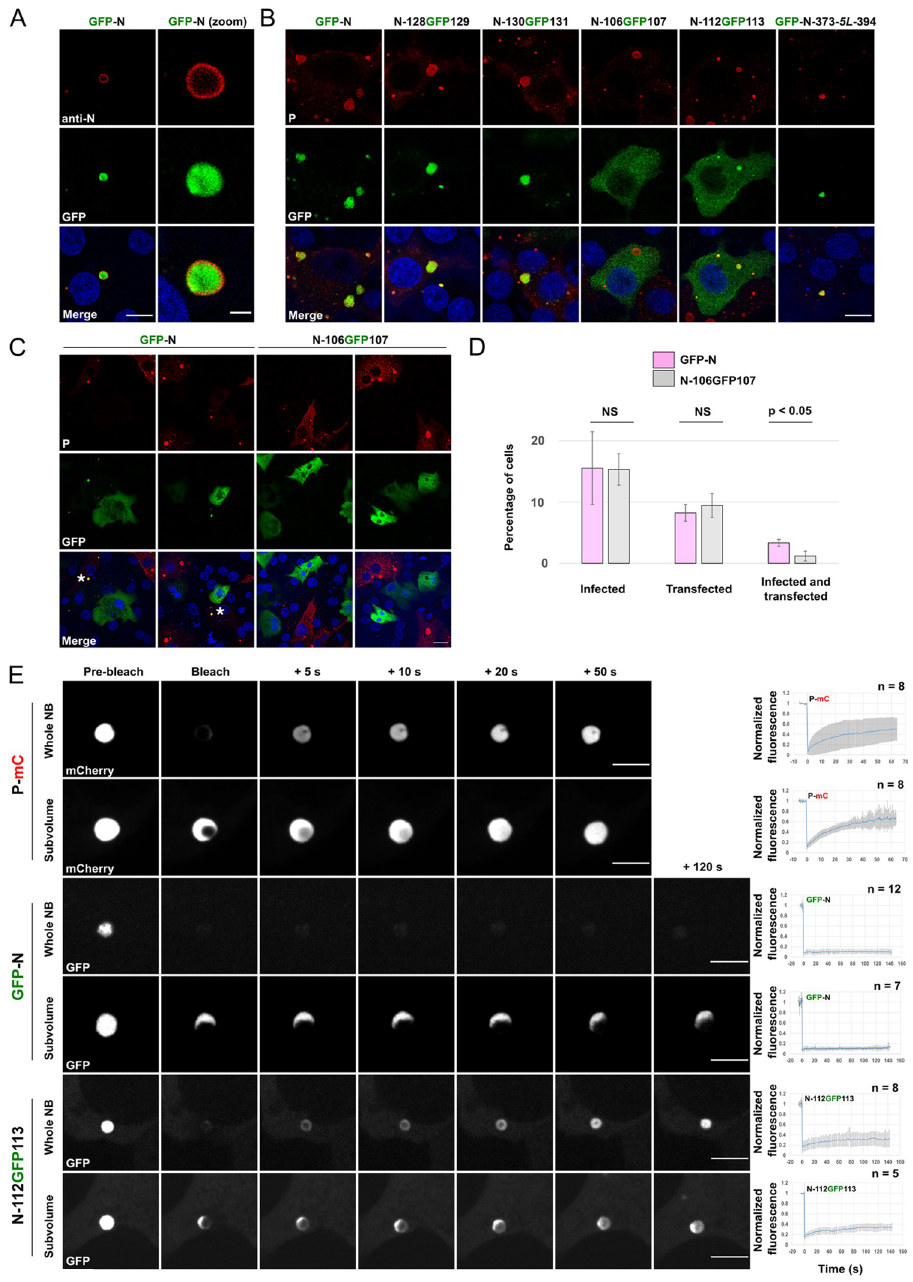
Fig 2. Characterization of the behavior of chimeras between GFP and N in RABV infected cells. A-C) BSR-T7/5 cells were infected at an MOI of 0.5 by RABV (CVS strain) and transfected 1h post adsorption with pTit plasmids encoding the indicated N constructs. Cells were fixed 14 h post transfection and the localization of viral proteins and ectopically expressed N mutants was assessed by fluorescence confocal microscopy. A) N protein (either virally encoded or in the GFP-N chimera) was revealed with a mouse monoclonal anti-N antibody followed by incubation with Alexa-488 goat anti-mouse IgG. Scale bars: 10 μ m and 2 μ m for the magnified image. B) Localization of viral P protein (revealed with a rabbit polyclonal anti-P antibody followed by incubation with Alexa-568 donkey anti-rabbit IgG) and GFP-N chimeras in RABV infected cells. Scale bar: 10 μ m. C) Effect of GFP-N and N-106GFP107 expression on RABV cell infection. P was revealed with a rabbit polyclonal anti-P antibody followed by incubation with Alexa-568 donkey anti-rabbit IgG. Asterisks indicate cells that are infected and express GFP-N. Note that GFP-N localization is diffuse in the cells that are not infected. Infected cells expressing N-106GFP107 are rare and absent in the displayed field. Scale bar: 10 μ m. D) Percentages of infected, transfected, as well as both infected and transfected cells (for